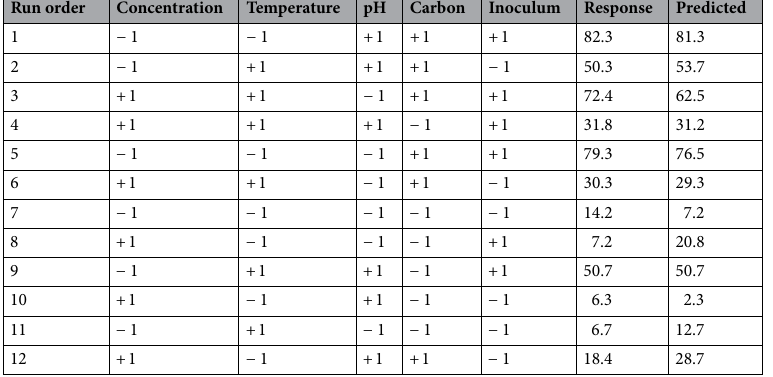
Table 1. Plackett–Burman design (PBD) of factors (in coded levels) with biodegradation of chlorpyrifos (%) as